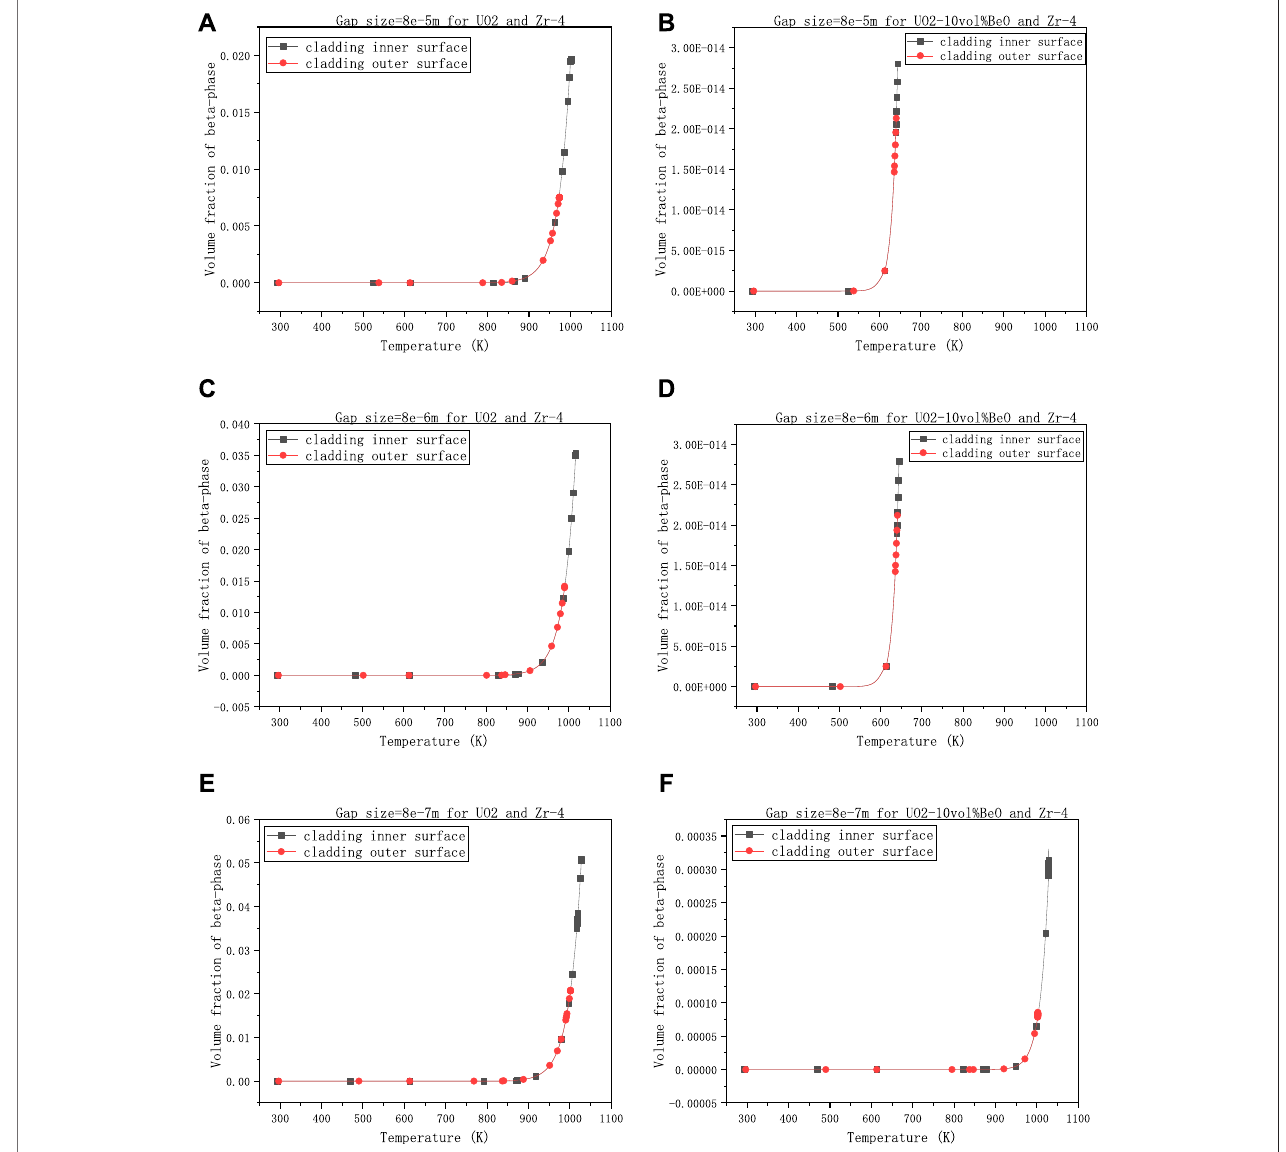
FIGURE 5 | Volume fractions of β -phase on cladding inner-surface and outer-surface, changing with the gap size between the fuel and cladding, (A) 8e − 5 m for UO 2 andZircaloy-4, (B) 8e − 5 mforUO 2 -10vol%BeOandZircaloy-4, (C) 8e − 6 mforUO 2 andZircaloy-4, (D) 8e − 6 mforUO 2 -10vol%BeOandZircaloy-4, (E) 8e − 7 mfor UO 2 and Zircaloy-4, (F) 8e − 7 m for UO 2 -10vol%BeO and Zircaloy-4.